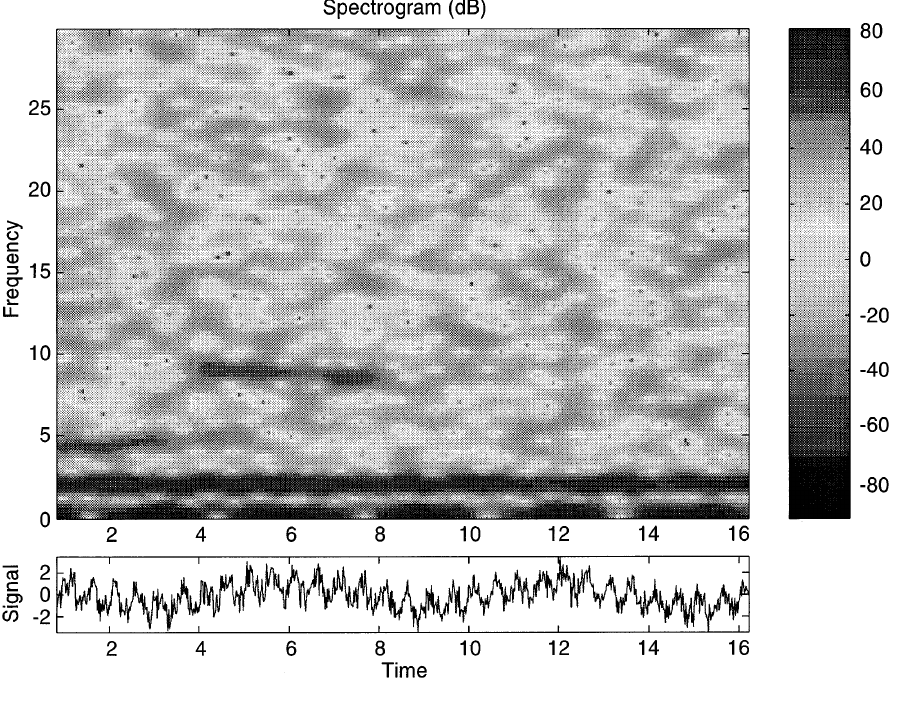
Fig. 3. Spectrogram of the synthetic signal in the noisy case; frequencies are in h